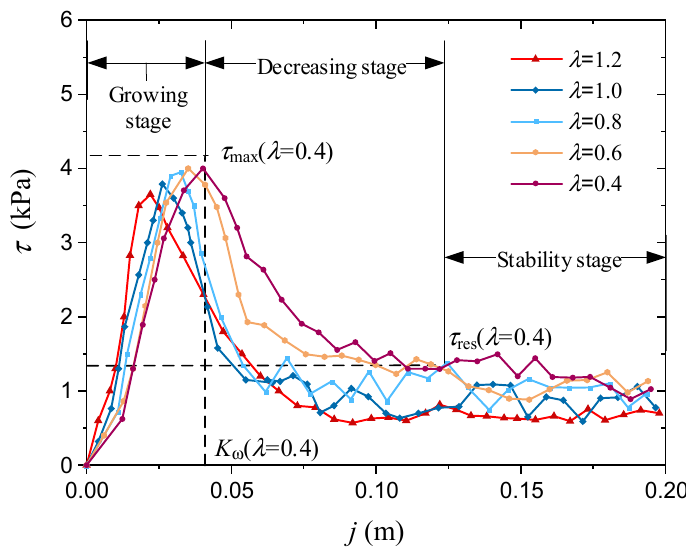
Figure 7. DEM simulation curves of shear stress.